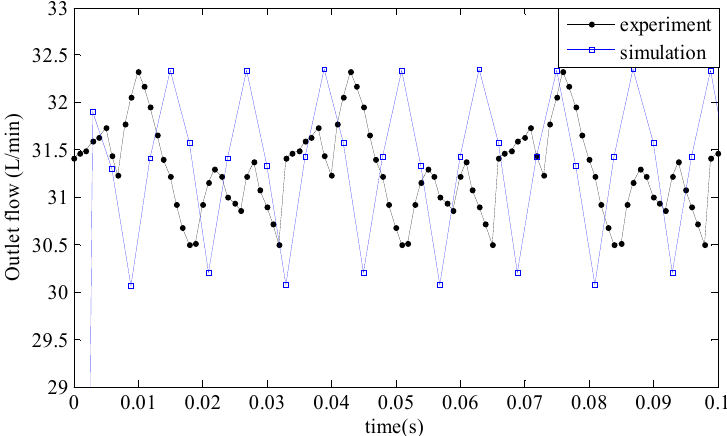
Figure 14. Comparison of the outlet flow of the experiment and simulation after optimization.